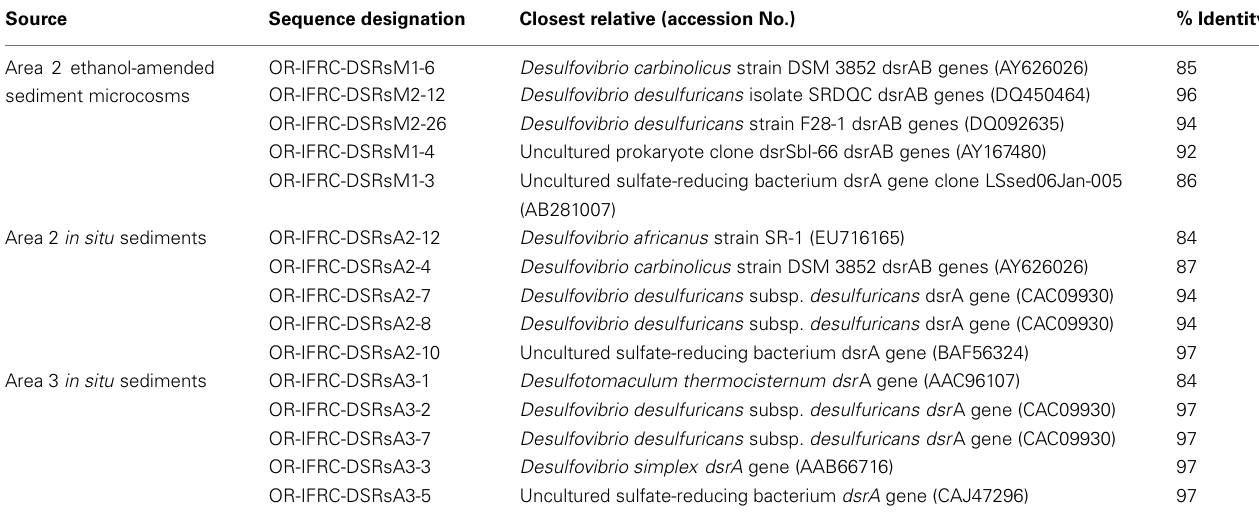
Table 2 | Partial dsr A mRNA sequences retrieved from OR-IFRC ethanol-amended microcosms and in situ sediment.